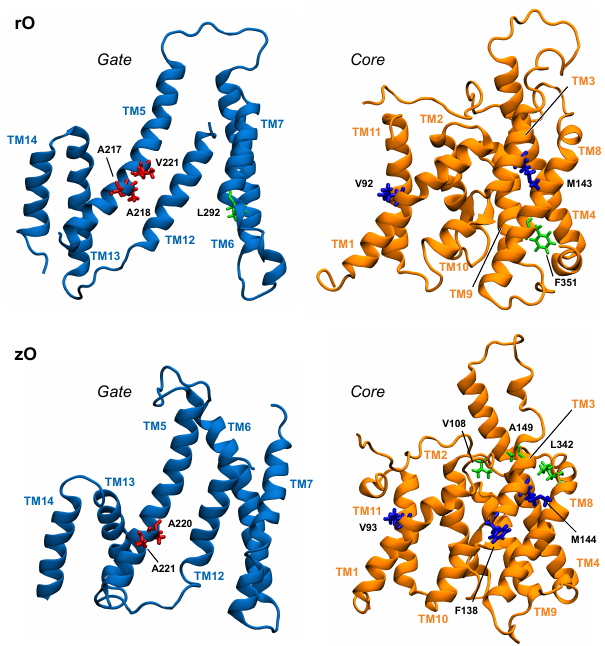
Figure 7. Position in the structure of gate and core domains of the network hubs (in licorice) in the outward-open simulations, as viewed from the interdomain interface. Residues on gate and core that are located at the interface are colored red and blue, respectively. Hub residues not located at the interface are colored